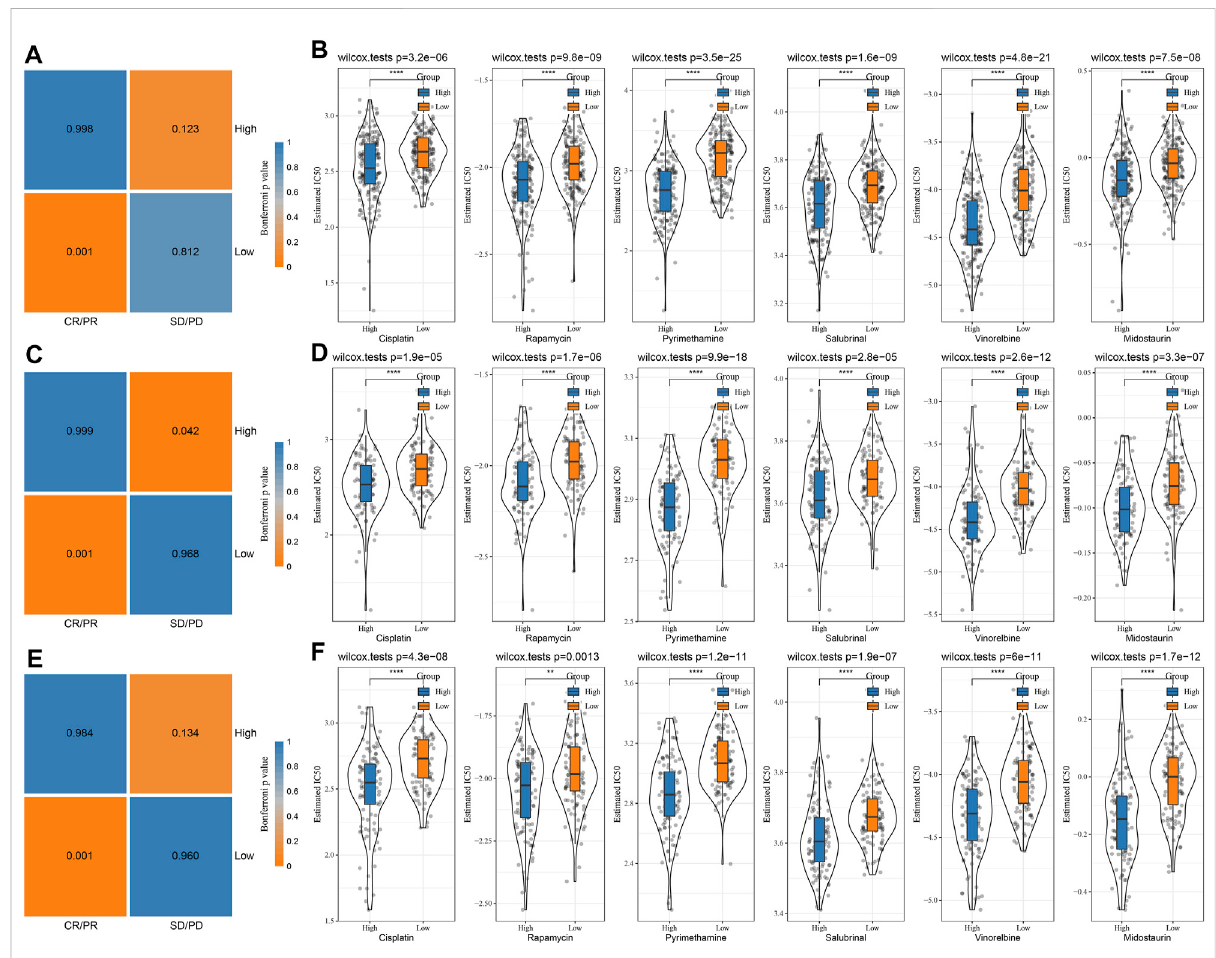
FIGURE 9 Immunotherapy mapping and drug sensitivity analysis. (A) Immunotherapy mapping of different risk groups of TCGA; (B) Estimated IC50 box diagram of cisplatin, rapamycin, pyrimethamine, salubrinal, vinorelbine, and midostaurin in TCGA; (C) Immunotherapy mapping of different risk groups of HCCDB18; (D) Estimated IC50 box diagram of cisplatin, rapamycin, pyrimethamine, salubrinal, vinorelbine and midostaurin in HCCDB18; (E) Immunotherapy mapping of different risk groups of GSE14520; (F) Estimated IC50 box diagram of cisplatin, rapamycin, pyrimethamine, salubrinal, vinorelbine and midostaurin in GSE14520. (ns, p > 0.05; * * *, p < 0.001; * *, p < 0.01; *, p <